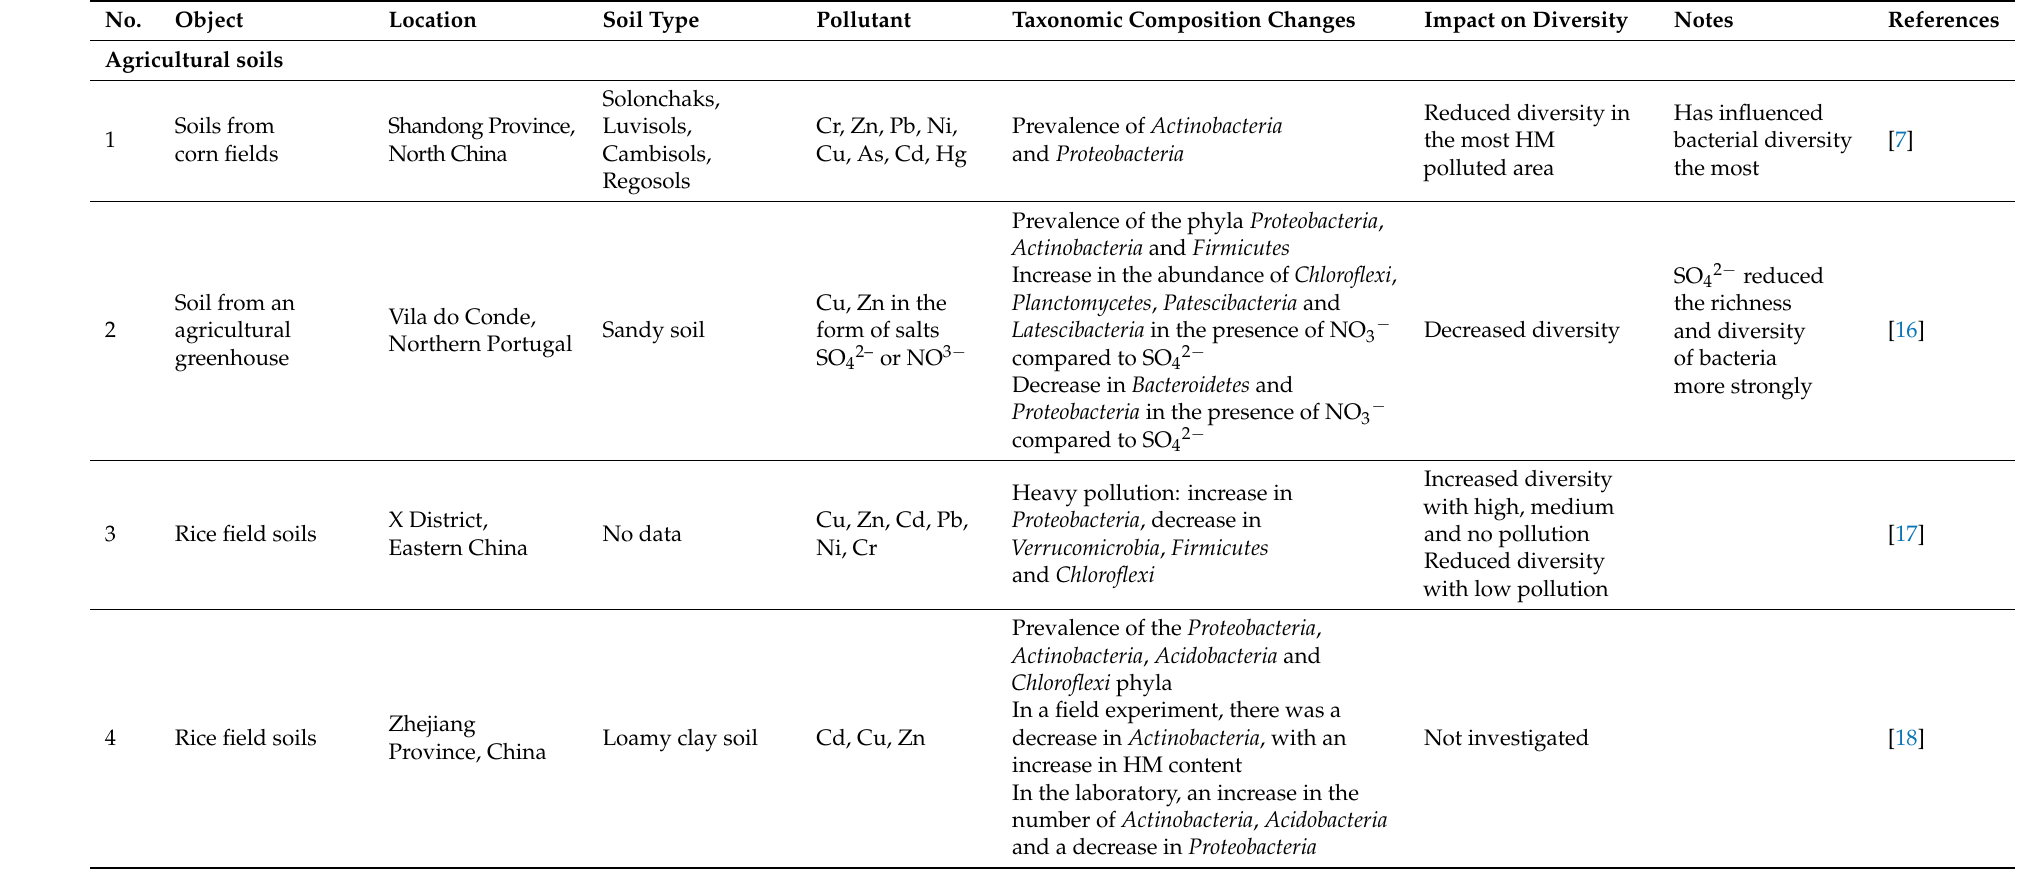
Table 1. Effect of heavy metals on the soil bacterial